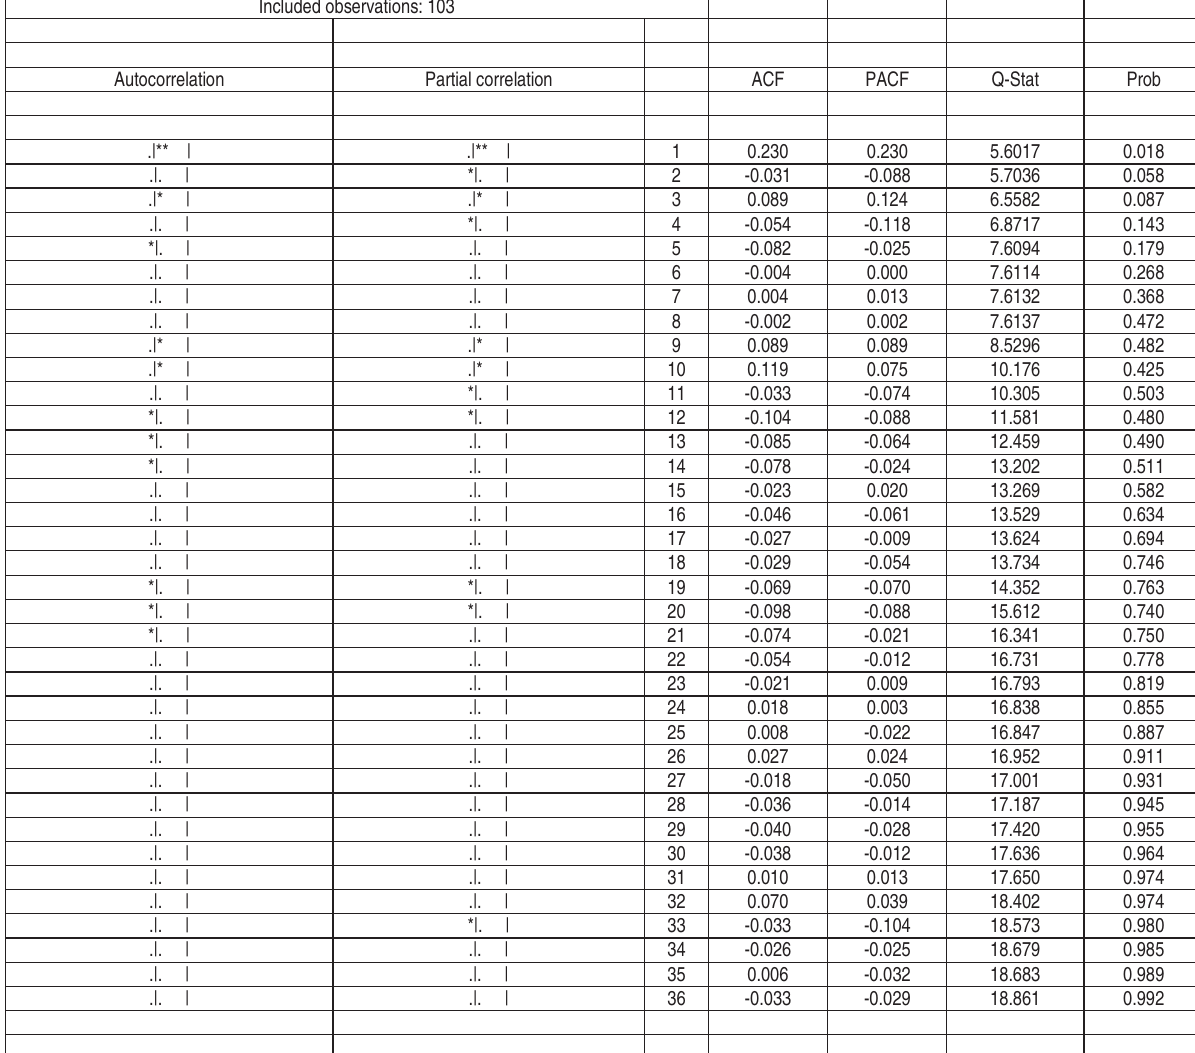
Table 1. ACF and PACF correlogram of square residuals for the weighted regression